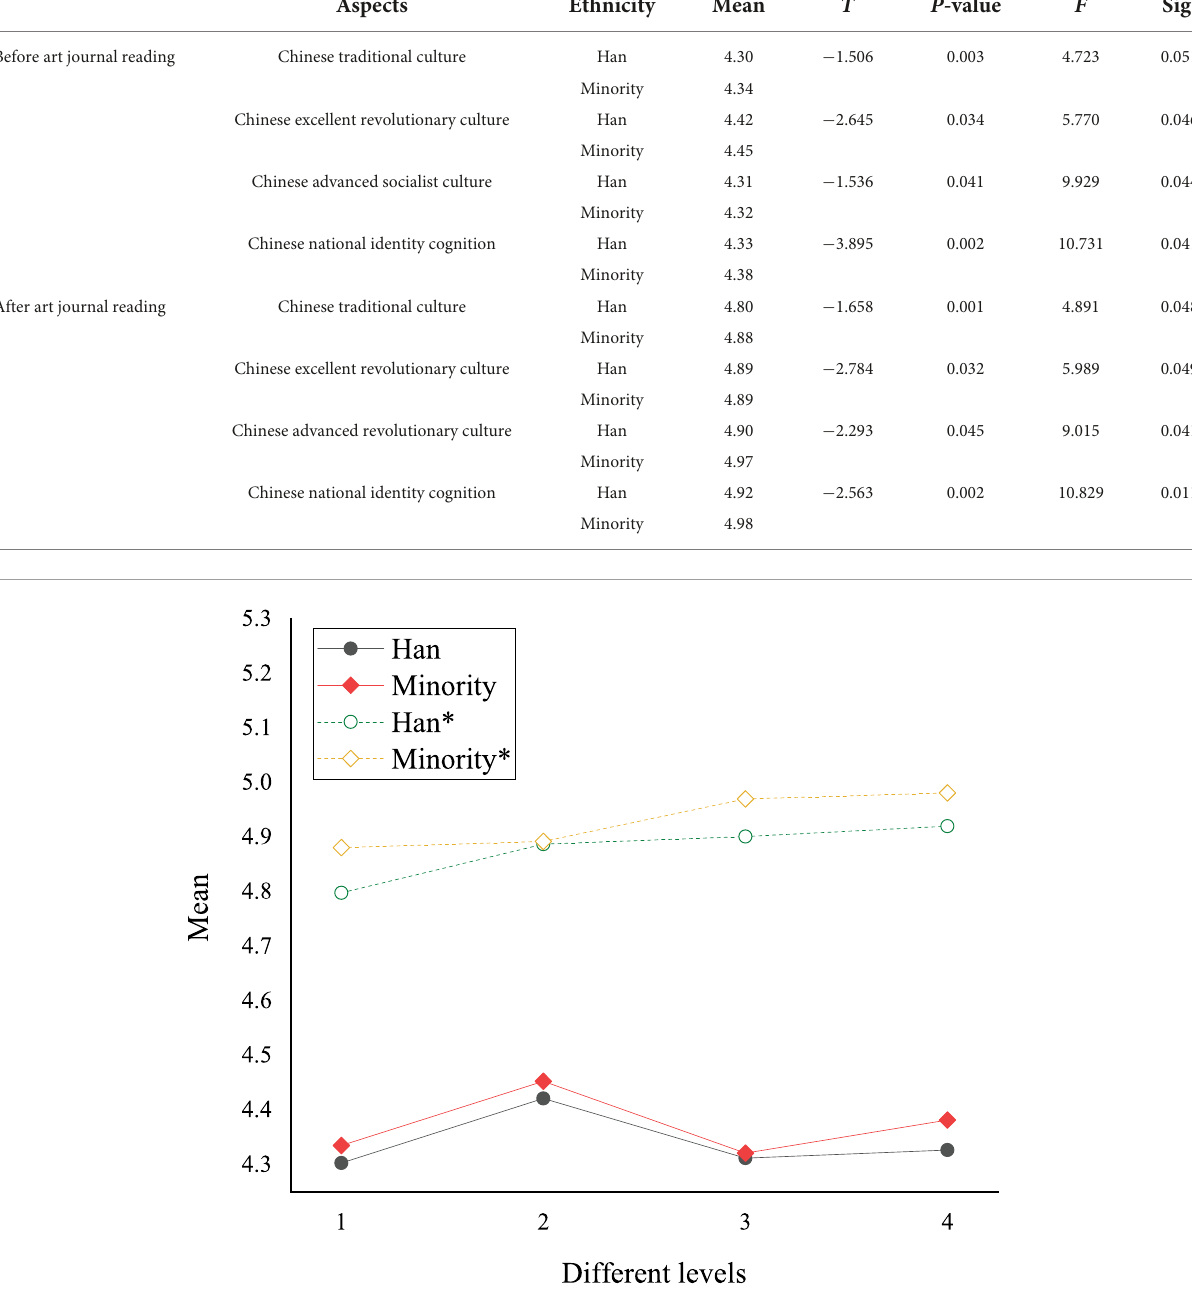
TABLE 4 Comparison of the national cognition and cultural acceptance of college students of different nationalities.